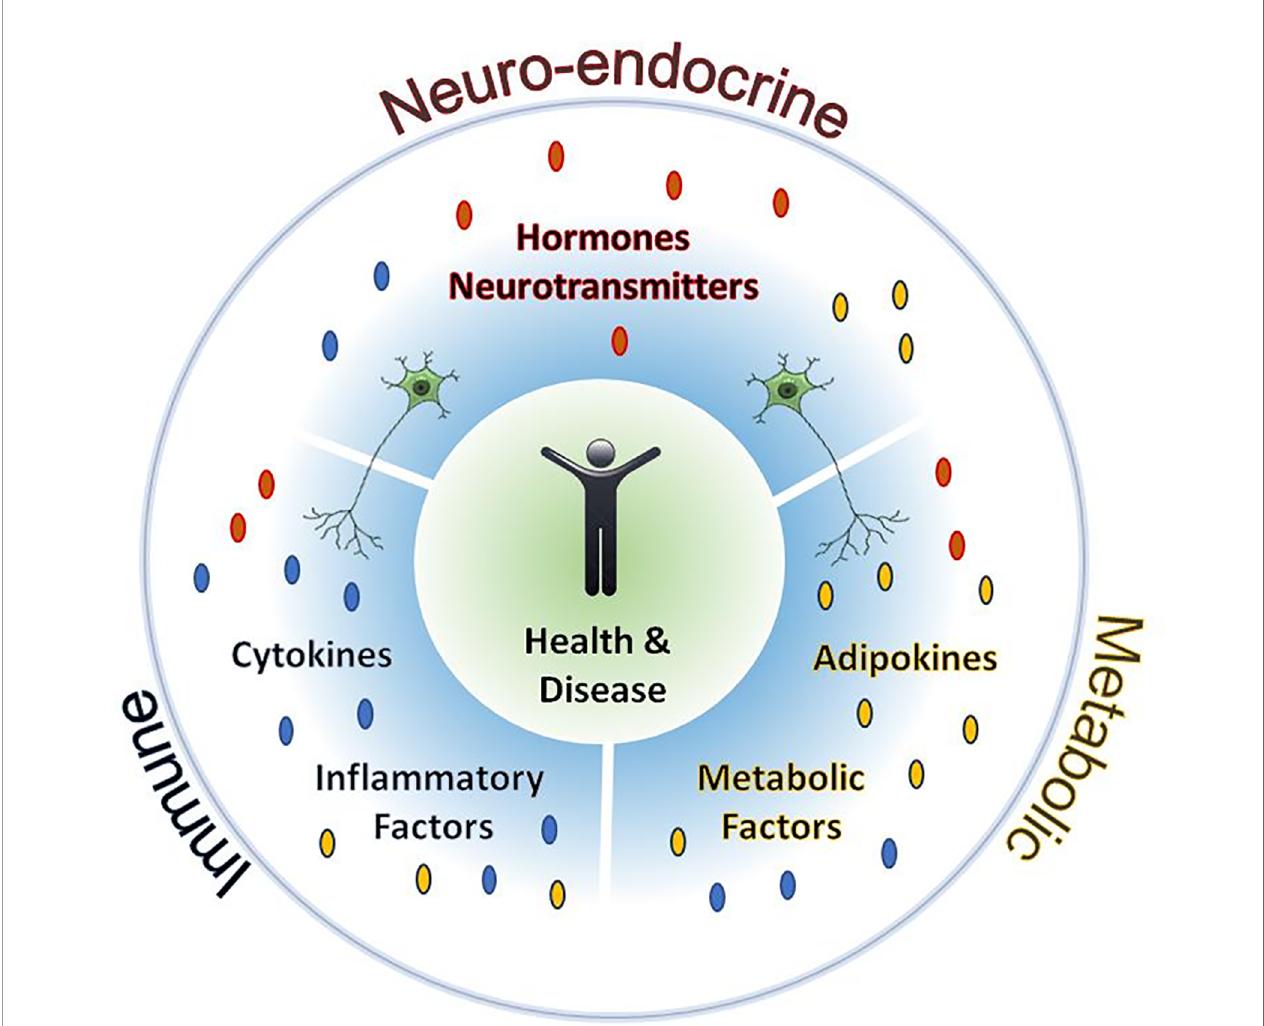
FIGURE 1 | Neuroendocrine, immune and even metabolic systems are interconnected by a profuse network of